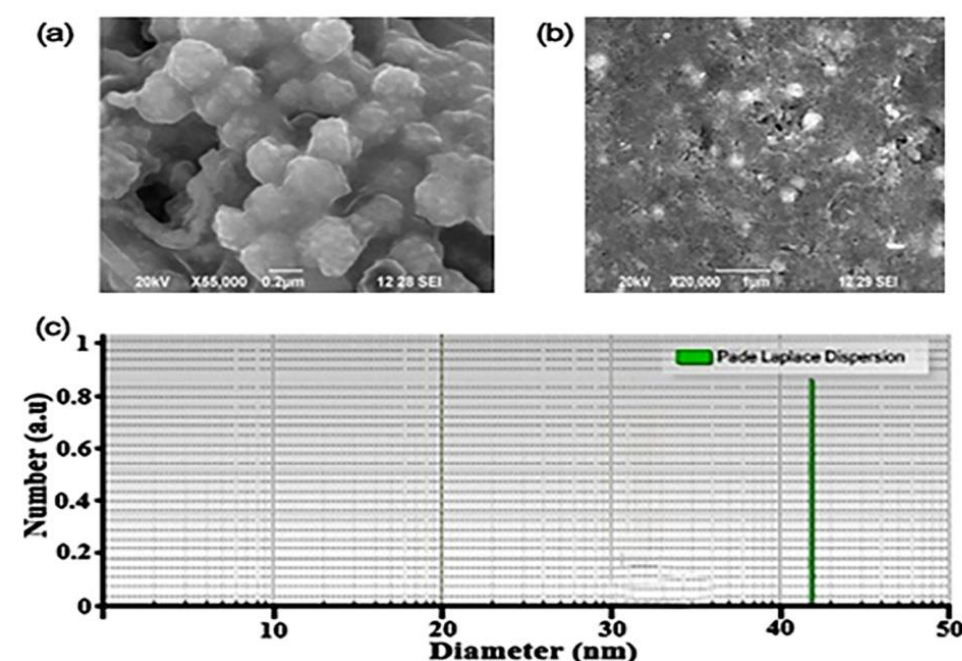
Figure 3. ( a , b ) SEM Image of MK-AgNPs. ( c ) Particle size analyzer of